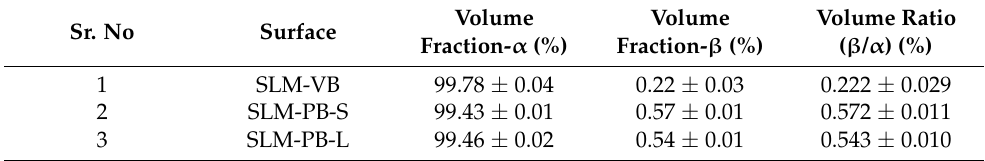
Table 5. The volume fraction of α phase and β